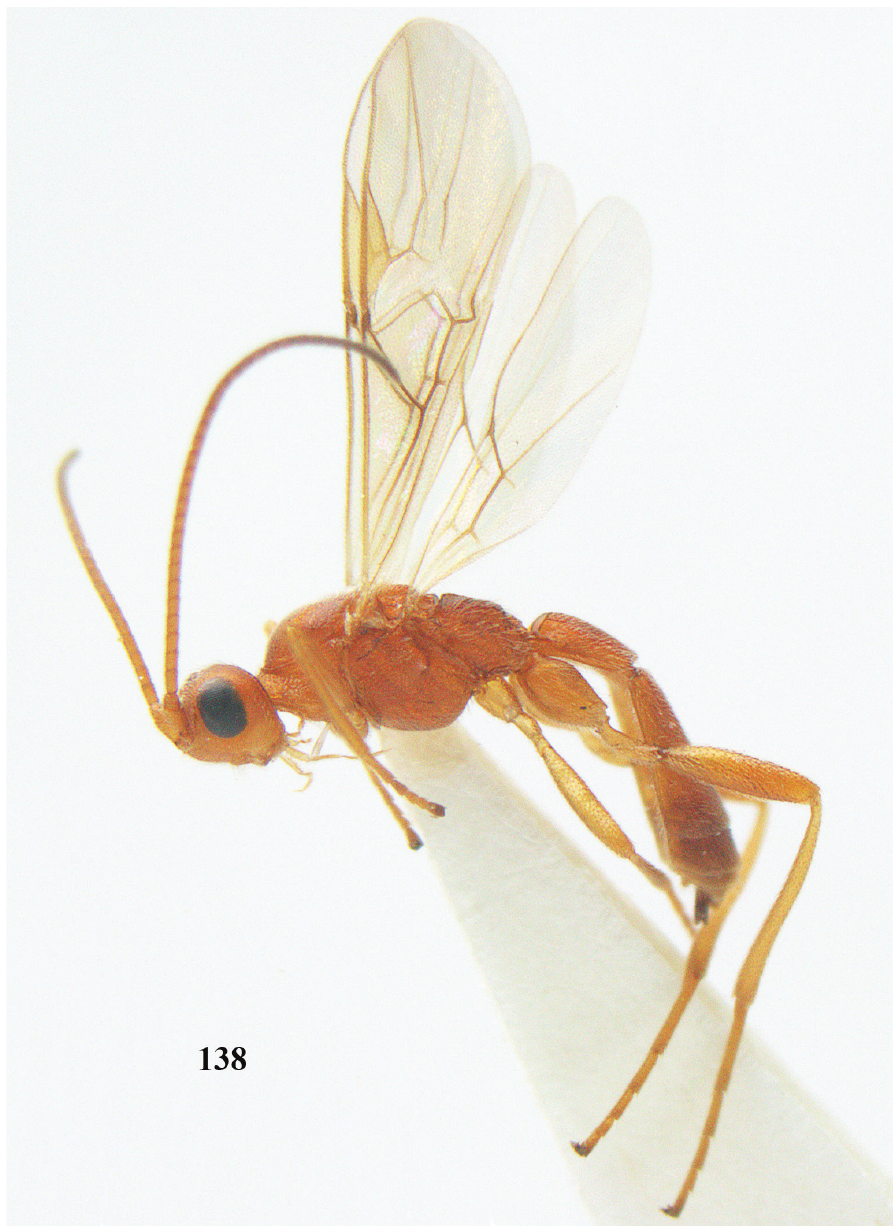
Figure 138. Aleiodes curticornis nom. n., ♀ , Italy, Tyrol, near Laudes, habitus lateral. Molecular data. MRS056 (Corsica JF962825, CO1), MRS336 (Italy JF973341, CO1), MRS338 (Italy KU682235, CO1]), MRS342 (Italy KU682236, CO1), MRS343 (Italy JF962826/KU682237,